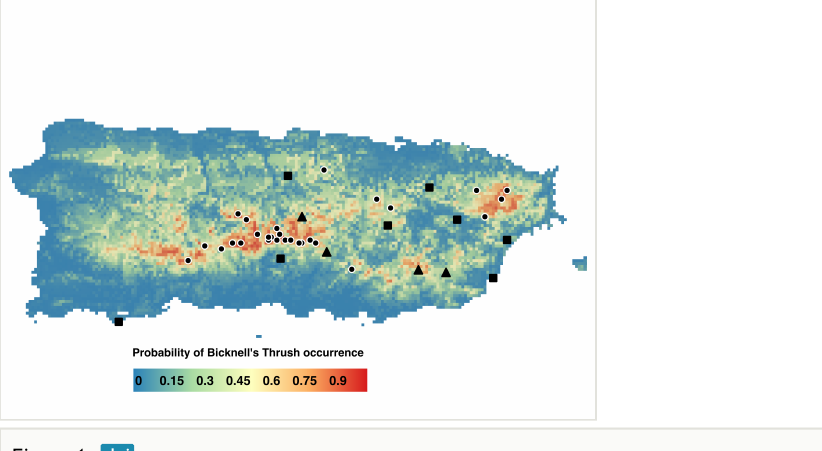
Figure 1. Location of 1-km2 cells on Puerto Rico surveyed for forest birds during 2015. Geographic distribution of sampling locations was based on the predicted probability of occurence of Bicknell's Thrush: 29 cells had a high predicted probability of occurrence of Bicknell’s Thrush (black dots); 5 had a medium (black triangles) and 9 had a low (black squares) predicted probability of occurrence (note that GPS coordinates were not recorded for 1 cell in each category, so only the 40 cells with coordinates are